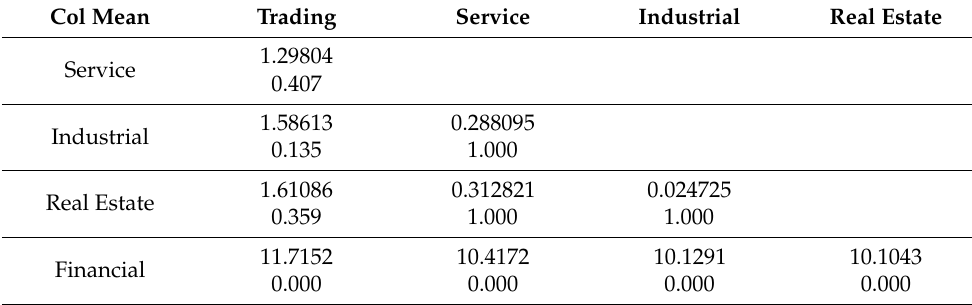
Table 8. Comparison of all FI disclosures by industries (Sidak) row mean.